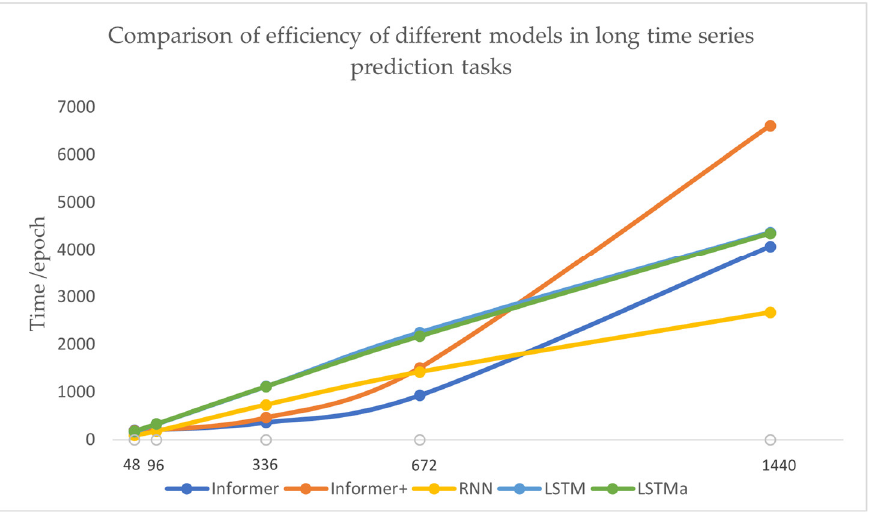
Figure 12. Efficiency comparison of five models in power-load forecasting.